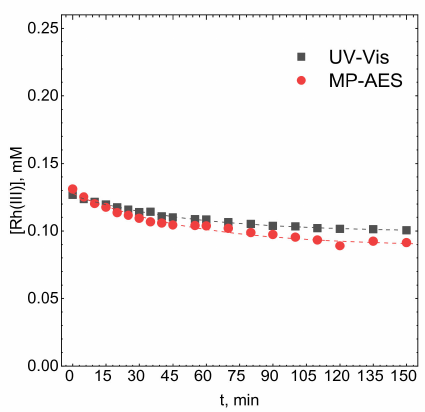
Figure 5. Kinetic curves obtained using the UV-Vis and MP-AES techniques. Experimental conditions: T = 50 ◦ C, [C] = 0.5 g, pH = 1, [Br] − = 0.1 M, V = 1200 rpm, [Rh(III)] 0 ≈ 1.1 × 10 − 4